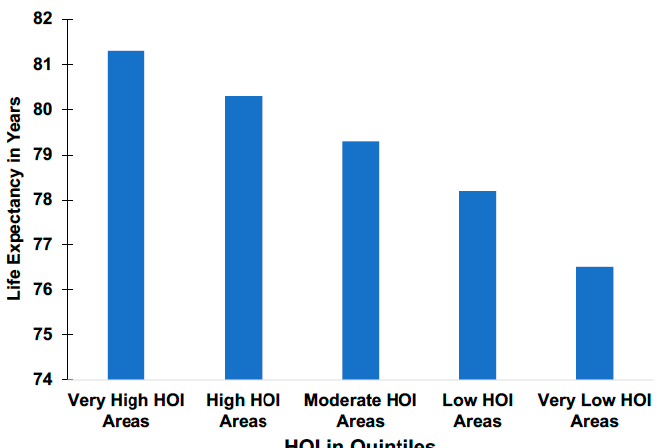
Figure 1. Health Opportunity Index Scaled into Quintiles against life expectancy to show the relationship. The relationship is monotonic indicating that persons living in “Very High Opportunity Areas” on average is expected to live over four more years compared to the persons in “Very Low Opportunity Areas”.